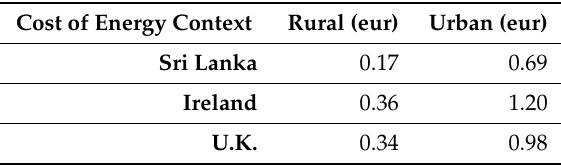
Table 2. Levelized Cost Of Energy (LCOE) for various countries for rural and urban contexts. Adapted from Sunderland et al.